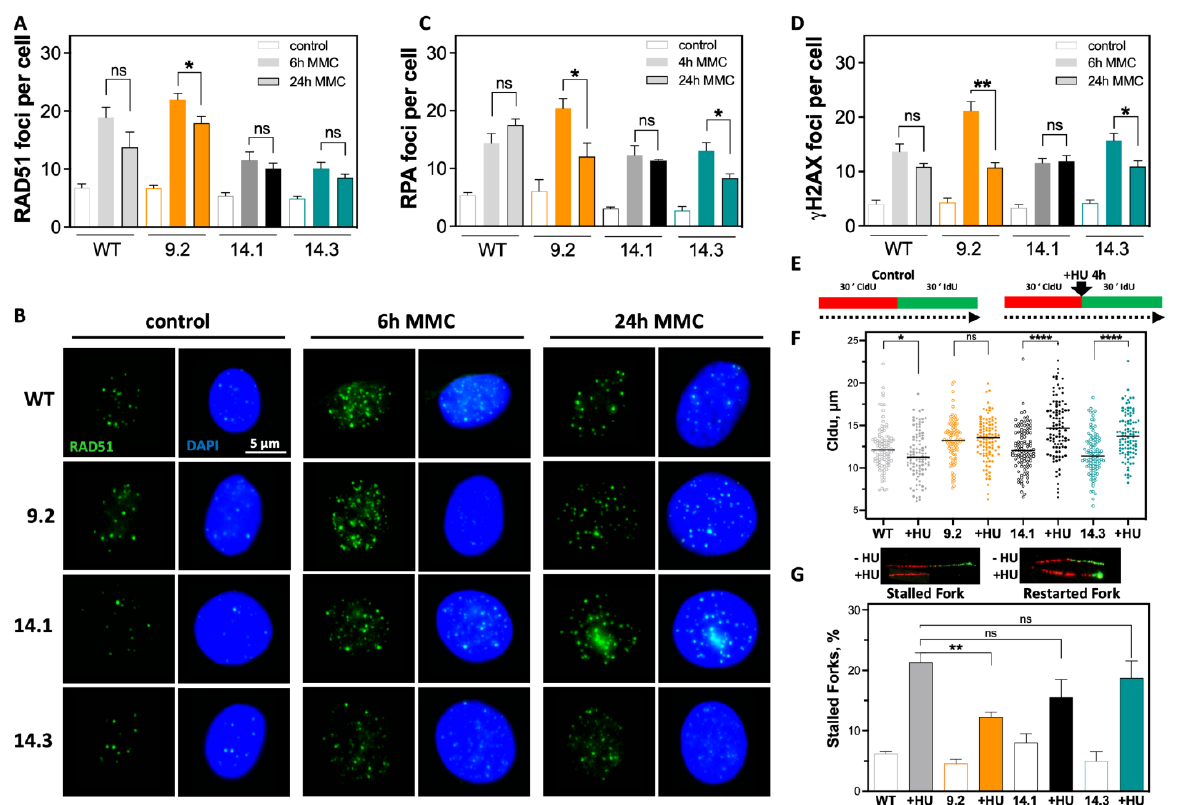
Figure 3. Resistance indicates more efficient DSB repair and avoidance of replication ‐ associated DNA damage. ( A – D ) Formation of DNA repair foci after MMC treatment. ( A , B ) RAD51 foci (green) 6 h and 24 h after treatment with 0.5 μ g/mL MMC for 1 h, ( C ) quantification of RPA foci 4 h and 24 h after MMC, and ( D ) γ H2AX foci 6 h and 24 h after using the same protocol. Nuclei were counterstained with DAPI. γ H2AX foci were quantified manually; RAD51 and RPA foci were quantified using the Aklides ® NUK system (MediPan). Scale bar represents 5 μ m (40× magnification). At least 100 cells were analyzed in each biological replicate. ( E – G ) DNA fiber assay after treatment with HU for 4 h, in MCF7 WT and BRCA1 mutated clones. ( E ) Treatment scheme shows sequential labeling with CldU and IdU for 30 min each and addition of HU for 4 h between CldU and IdU. Incorporated nucleotides were detected by immunofluorescence. The length of the DNA fibers was measured with the ImageJ 1.52n software. ( F ) DNA fiber length of DNA strands already synthesized before HU administration and ( G ) number of replication forks halted within the next 30 min after HU removal. Shown are the mean values of three independent experiments ± SEM. Asterisks (*) indicate significant differences (* p < 0.05; ** p < 0.01, **** p < 0.0001; ns = not significant Student’s t ‐ test).